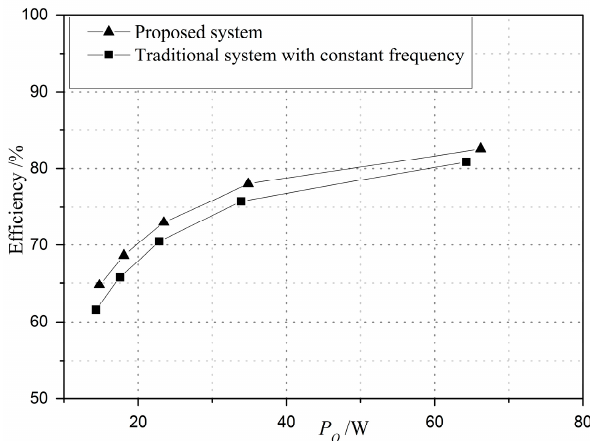
Figure 23. Efficiency of traditional system and proposed system.